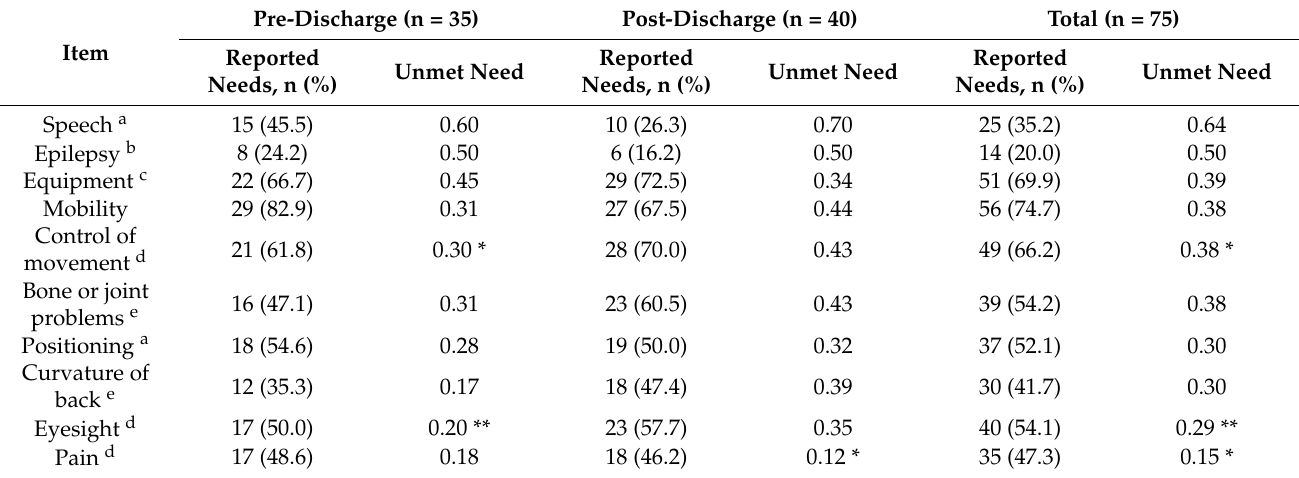
Table 5. Reported needs and unmet needs as a proportion of